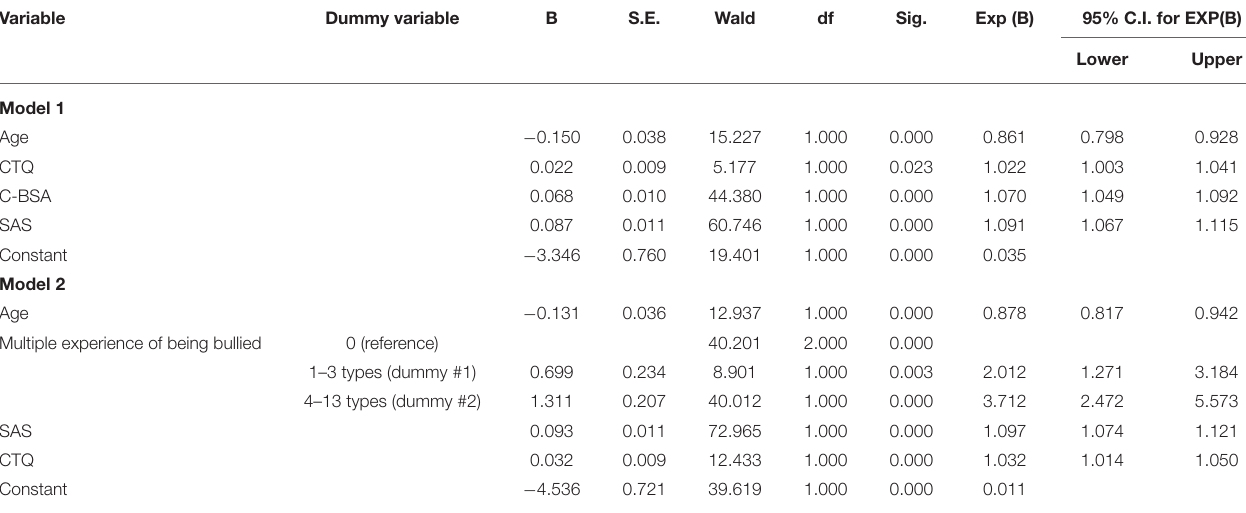
TABLE 3 | Multivariate logistic regression analyses for predicting psychosis-like experiences (PLEs) ( N = 1,258).